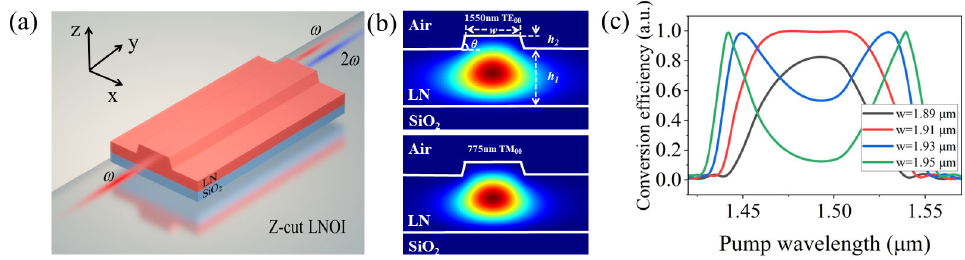
Figure 4. ( a ) Schematic of the LN ridge waveguide and working principle of SHG. ( b ) The fundamental quasi-TE mode profiles of the FW and the fundamental quasi-TM mode of the SHW in the ridge waveguide, where h 1 = 1.35 μ m, h 2 = 0.3 μ m, w = 2 μ m, and θ = 75°. ( c ) The conversion efficiency spectra with the waveguide length of L = 5 mm at 20 °C .